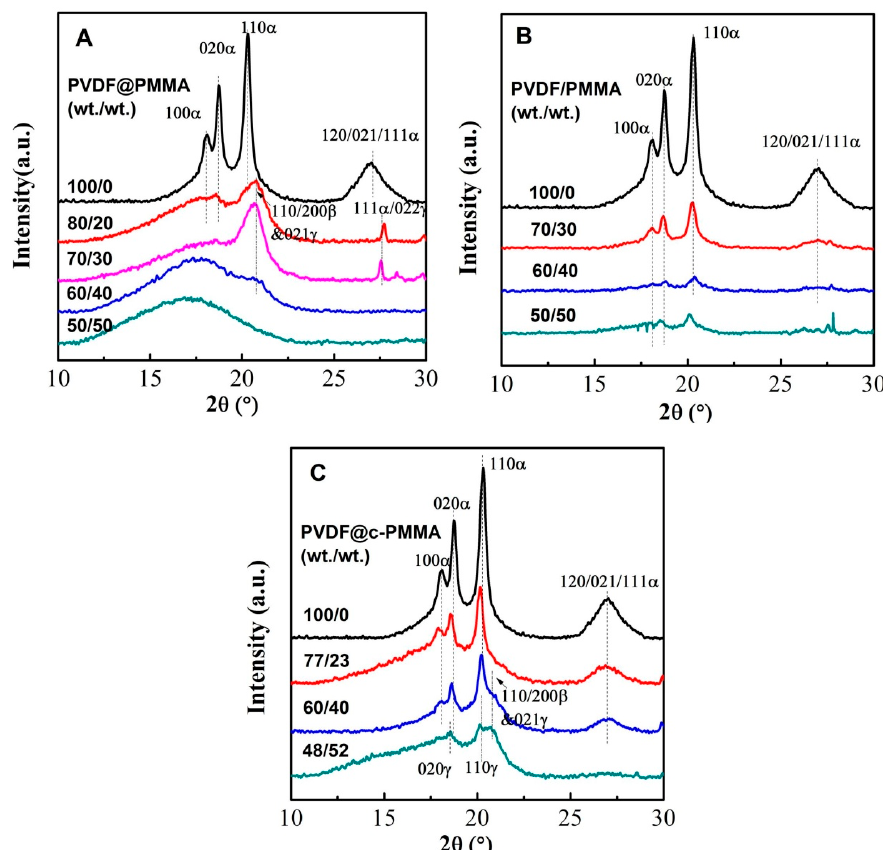
Figure 8. Wide-angle X-ray diffraction (WAXD) profiles of three series of the samples: ( A ) PVDF@PMMA; ( B ) PVDF/PMMA; and ( C ) PVDF@c–PMMA, at various weight